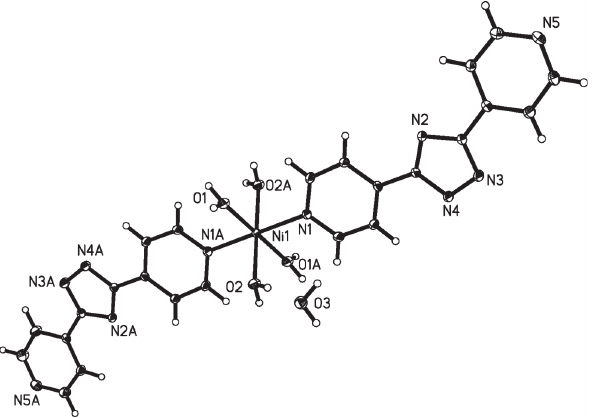
Table 2: Fractional atomic coordinates and isotropic or equivalent isotropic displacement parameters (Å 2